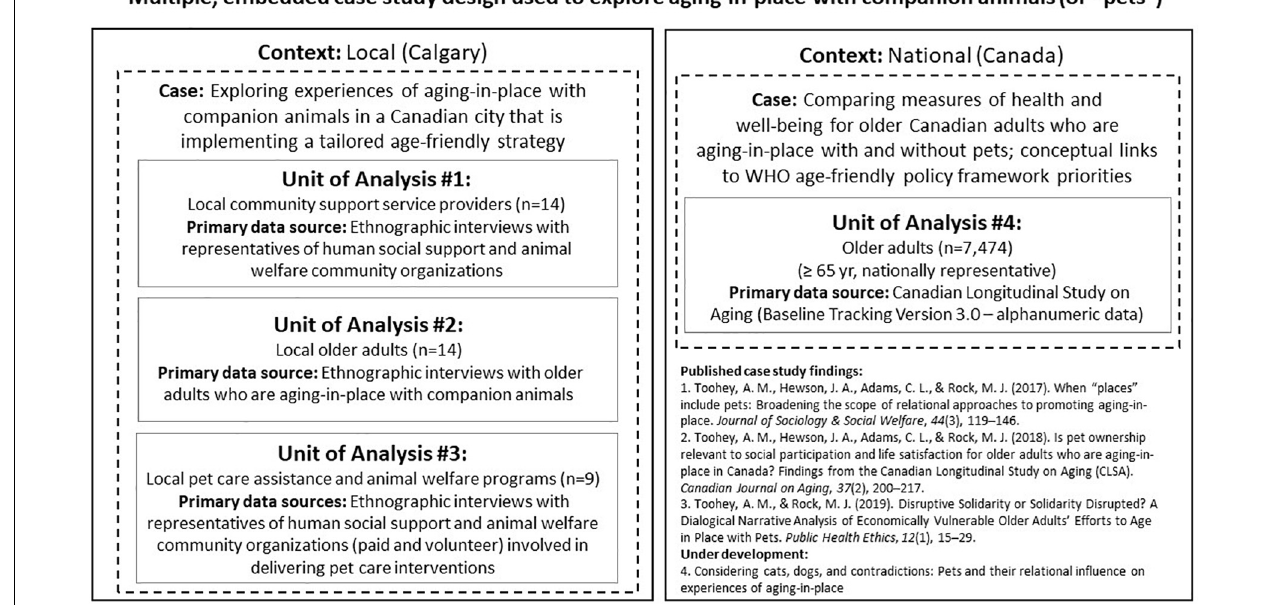
FIGURE 1 | Multiple, embedded case study design and scholarly outputs. Note that this study reports on findings from Unit of Analysis #3, while other scholarly outputs are listed within the